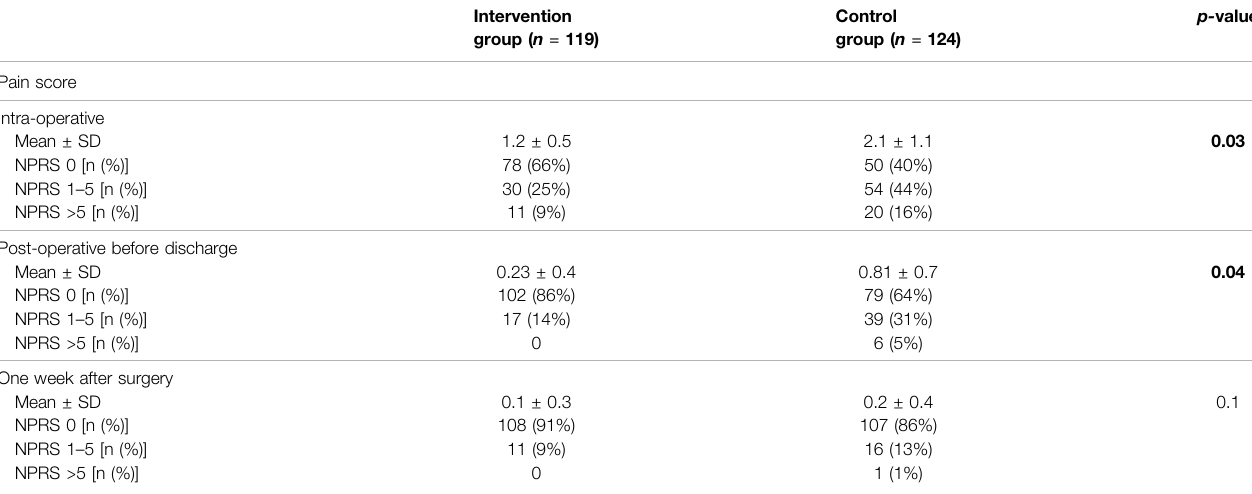
TABLE 3 | Pain score evaluated before and following cataract